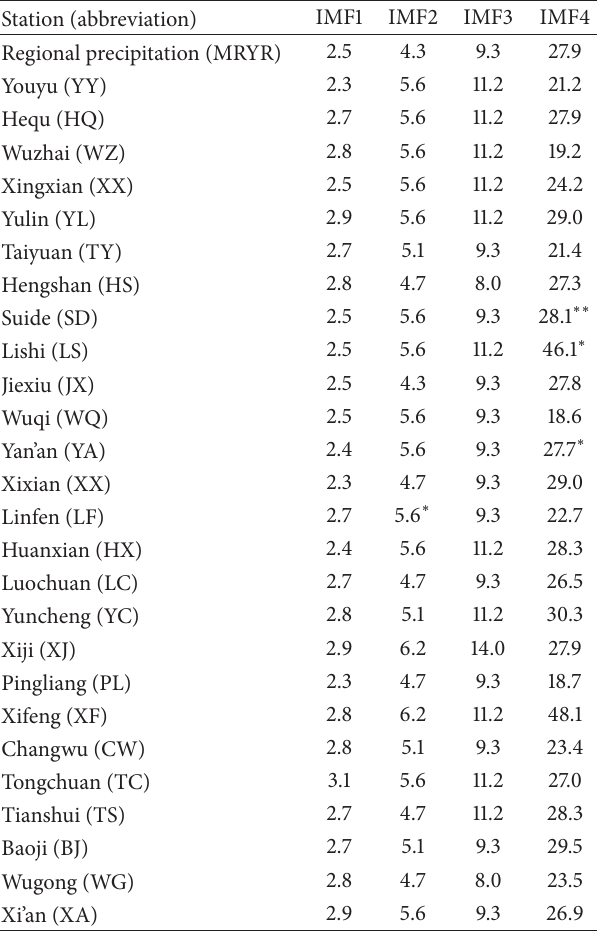
Table 4: The mean periods of various time-scale components for 𝑃 mf during 1958–2013 in the MRYR obtained by the